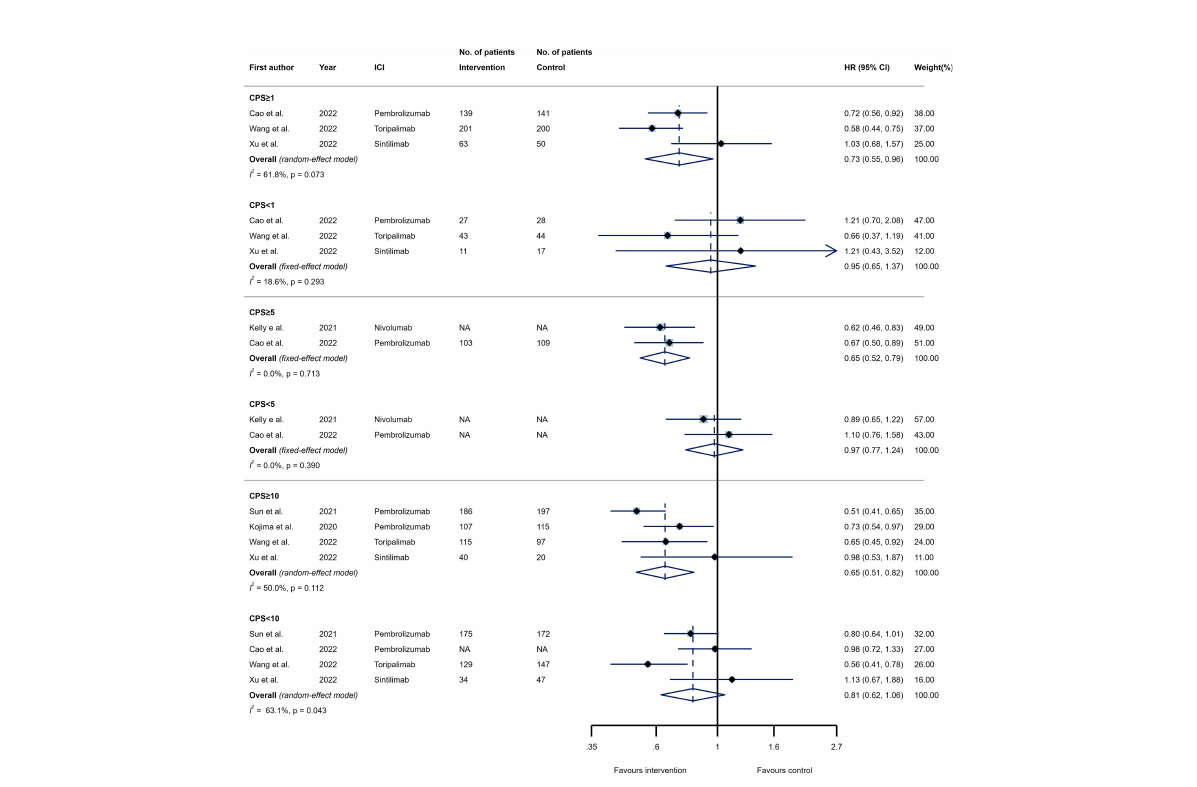
FIGURE 3 Forest plots of progression-free survival (PFS) in PD-L1 high expression group vs . PD-L1 low expression group for the thresholds of combined positive score (CPS)=1 (upper panel), CPS=5 (middle panel), and CPS=10 (lower panel). The squares indicate weight of each study based on the fi xed or random ‐ effect model. The vertical dashed line indicates the overall pooled estimate and the diamond the 95% con fi dence interval around that pooled estimate. The forest plot was generated using STATA 17.0 (STATA Corp, LLC,